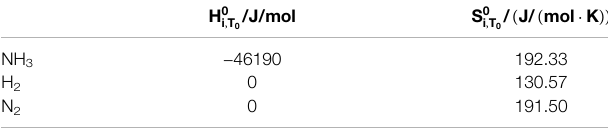
TABLE 3 | Enthalpy and entropy (T0 = 298.13 K).